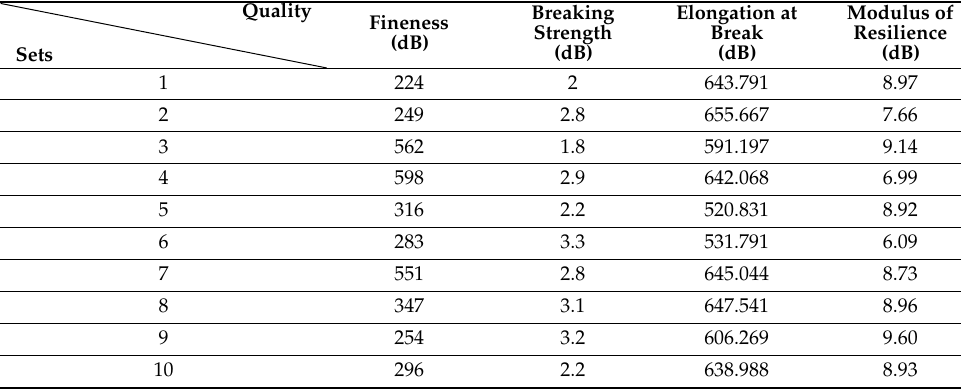
Table 9. Quality data for 10 abnormal samples.